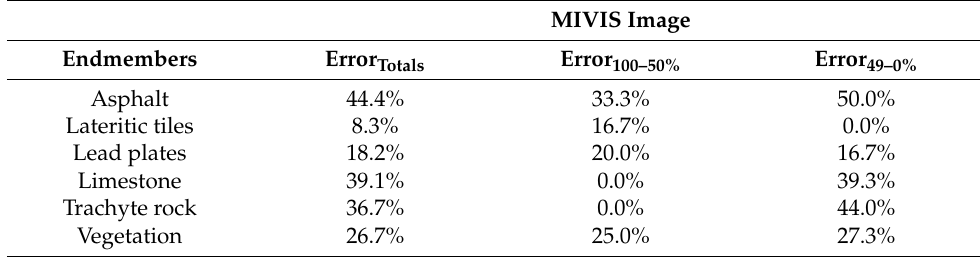
Table 6. The error in co-localization and spatial resampling evaluated by MIVIS image processing with Error Total , Error 100–50% , and Error 49–0% values.